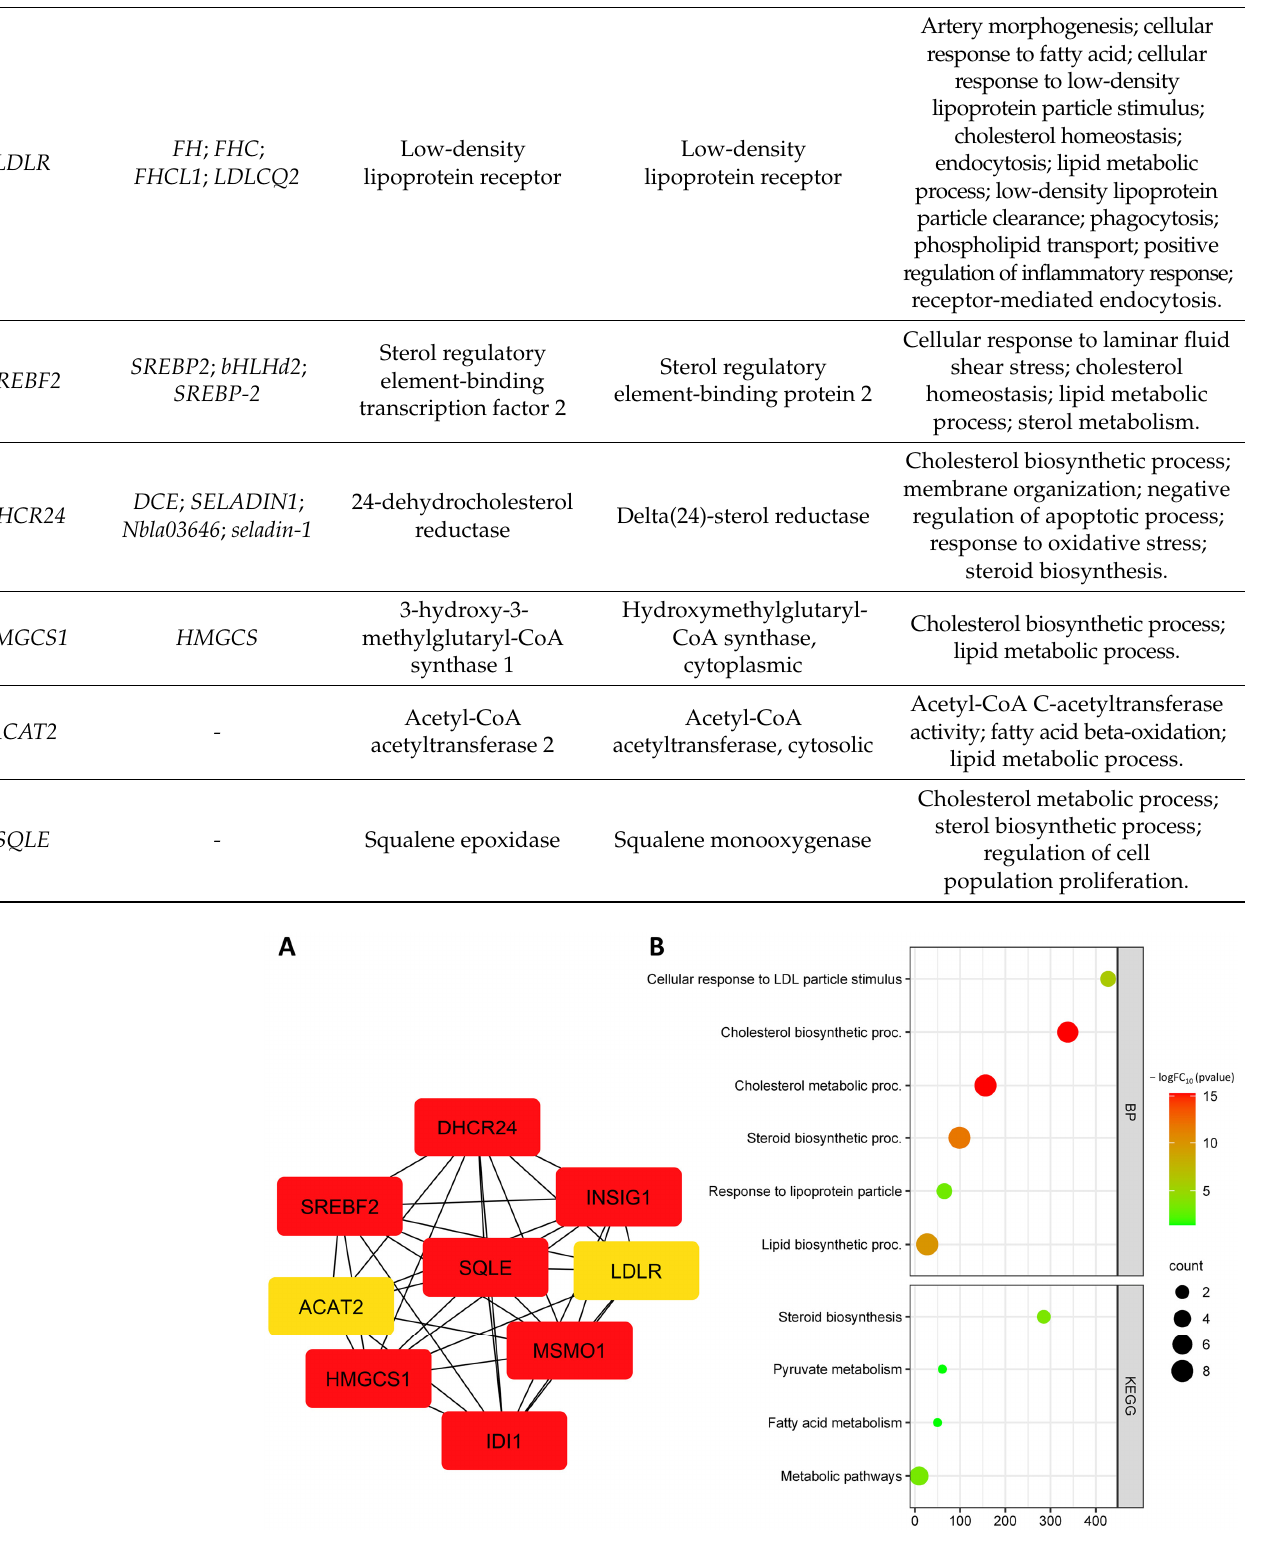
Figure 12. Down-regulated hub DEGs of the GSE29881 dataset ( A ); functional enrichment of down-regulated hub DEGs of the GSE29881 dataset ( B ). Note: the most important genes are ranked as follows: the most important genes are highlighted in red, less important genes in orange, even less important genes in yellow. 3.4. Identification and Functional Annotation of Common DEGs in Endothelial Cells under Dif- ferent Risk Factors Functional enrichment of common hub DEGs from the GSE103672, GSE141136, and GSE29881 datasets were analyzed. Up-regulated common hub DEGs are involved in bio- logical processes such as cytokine-mediated signaling pathway (GO:0019221), response to cytokine (GO:0034097), and innate immune response (GO:0045087). Up-regulated hub DEGs are involved in molecular functions such as arachidonate 5-lipoxygenase activity (GO:0004051), chemokine activity (GO:0008009), leukotriene-C4 synthase activity (GO:0004464), and antioxidant activity (GO:0016209). Up-regulated hub DEGs are in- volved in KEGG pathways such as RIG-I-like receptor signaling pathway (hsa04622), NF- kappa B signaling pathway (hsa04064), TNF signaling pathway (hsa04668), and NOD-like receptor signaling pathway (hsa04621) (Figure 13A). Down-regulated common hub DEGs were involved in biological processes such as cholesterol biosynthetic process (GO:0006695), protein targeting to ER (GO:0045047), translational initiation (GO:0006413), and lipid biosynthetic process (GO:0008610). Down- regulated hub DEGs are involved in molecular functions such as nitric-oxide synthase activity (GO:0004517), low-density lipoprotein particle binding (GO:0030169), and lipo- protein particle binding (GO:0071813). Down-regulated hub DEGs are involved in KEGG pathways such as steroid biosynthesis (hsa00100), HIF-1 signaling pathway (hsa04066), NOD-like receptor signaling pathway (hsa04621), apoptosis (hsa04210), fluid shear stress and atherosclerosis (hsa05418), lipid and atherosclerosis (hsa05417), and MAPK signaling pathway (hsa04010) (Figure 13B).